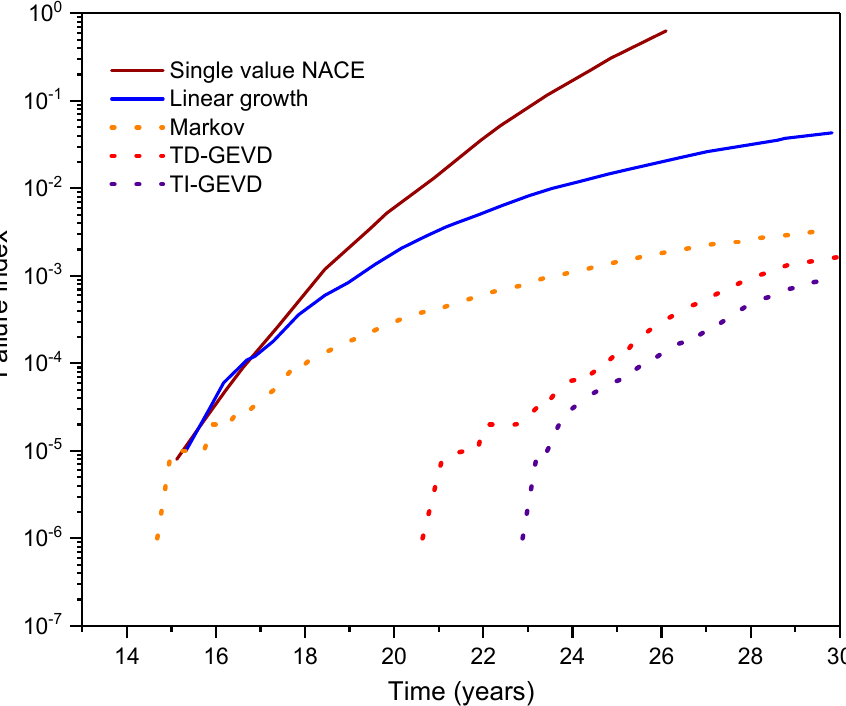
Figure 11. Evolution of the failure index in the pipeline studied and inspected by ILI and the prediction using five corrosion models. This figure was modified (color in lines was changed) using data from research conducted by Valor and coworkers reprinted with permission from ref. [93] Copyright 2022 Elsevier.